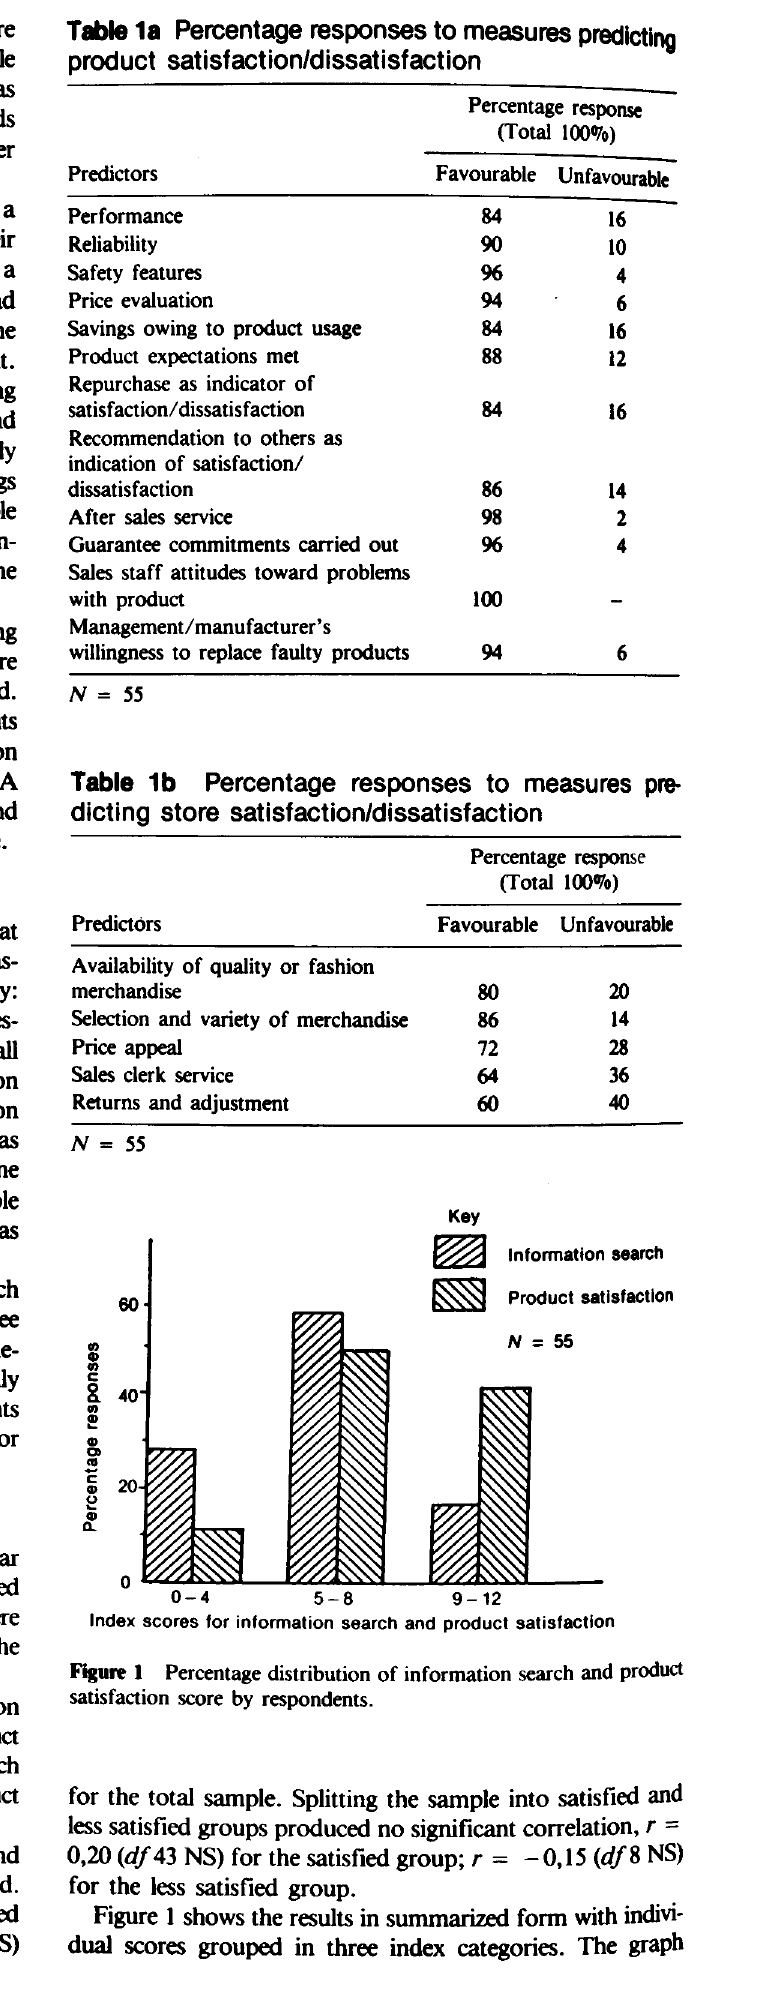
Figure 1 Percentage distribution of information search and product satisfaction score by